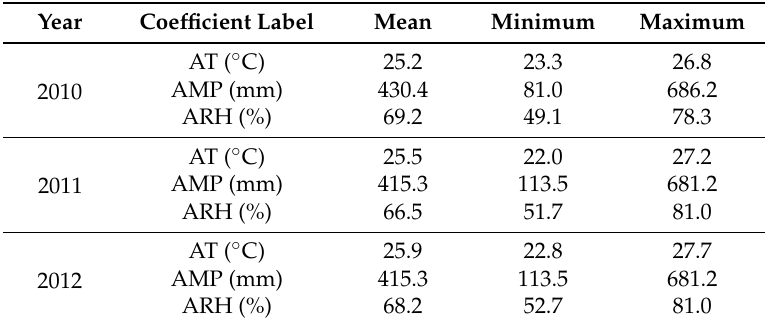
Table 6. AT, AMP and ARH from 2010 to 2012 in the 13 provinces in China with high probabilities of SFTSV